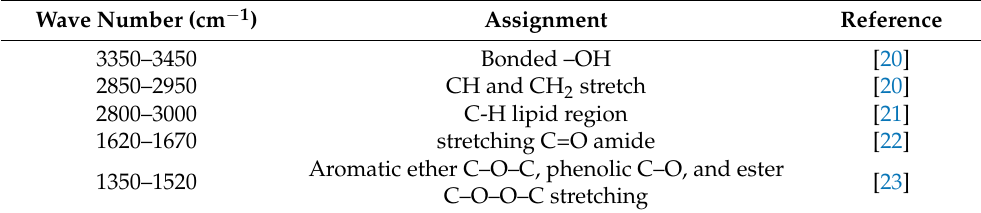
Table 1. List of band assignments for FTIR spectra of biogenic AgNPs.